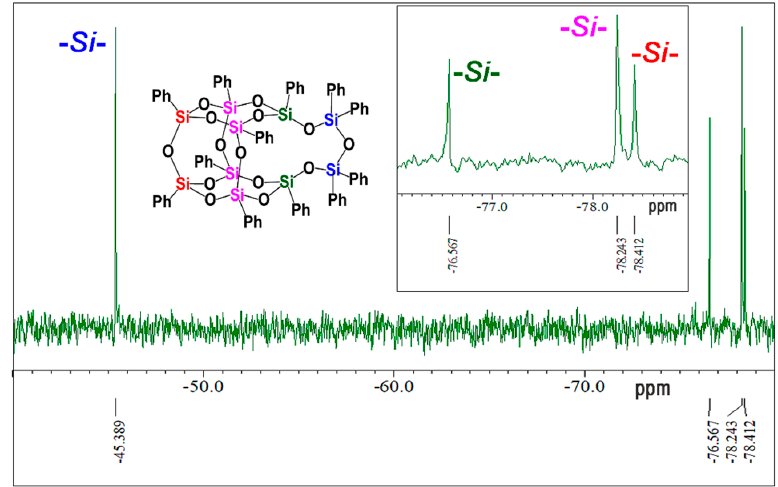
Figure 1. 29 Si{ 1 H}-NMR (119.2 MHz, CDCl 3 ) spectrum of 3 with labeled silicon positions. Table 1. 29 Si{ 1 H}-NMR data of all-phenyl siloxane compounds. Compound Si Unit Type Signal (ppm) T 8 -Ph [39] T